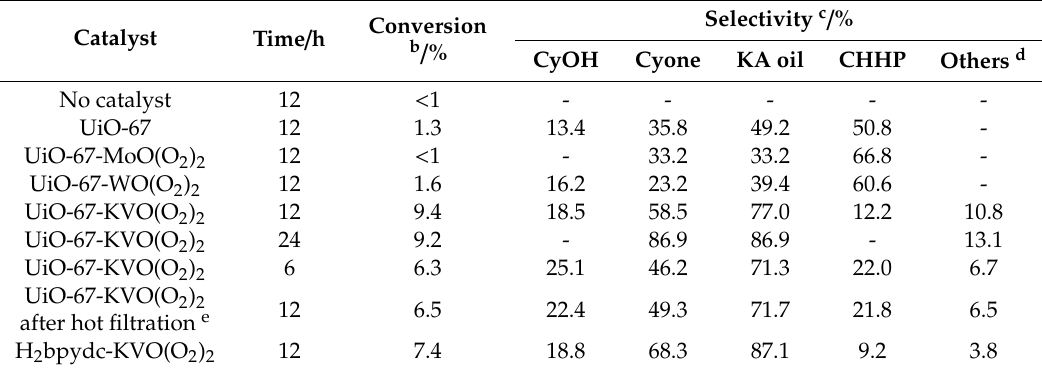
Table 2. The result of cyclohexane oxidation catalyzed by metal peroxide modified UiO-67 a .